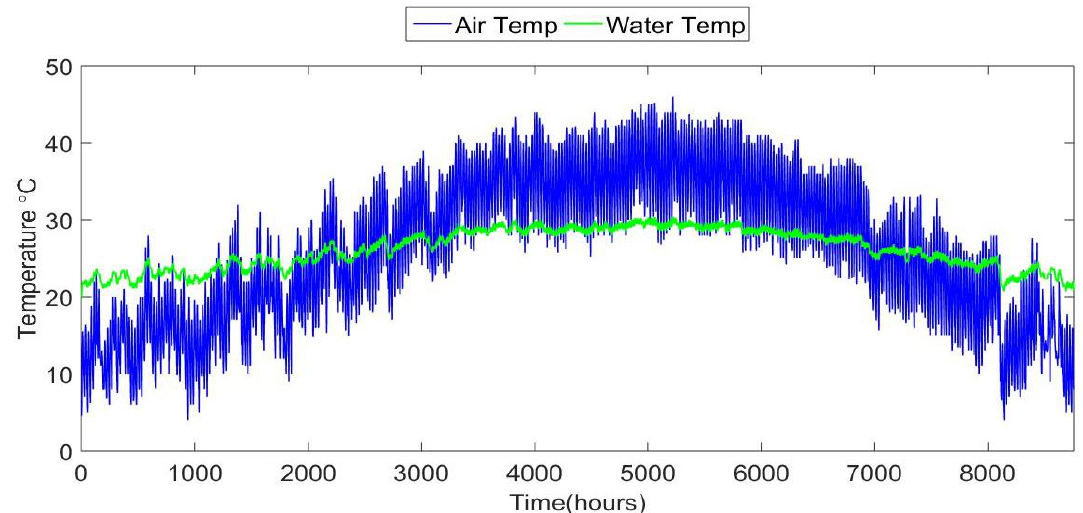
Figure 3. Ambient air temperature from TMY3 data, and water temperature model.